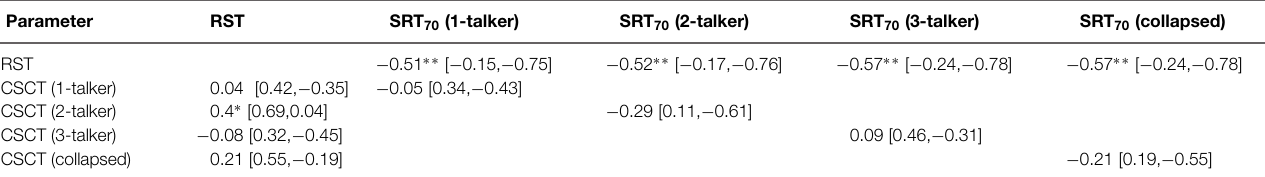
TABLE 4 | The correlation coefficients and their 95% confidence intervals (shown in brackets) for associations of interest between RST, CSCT, and SRT 70